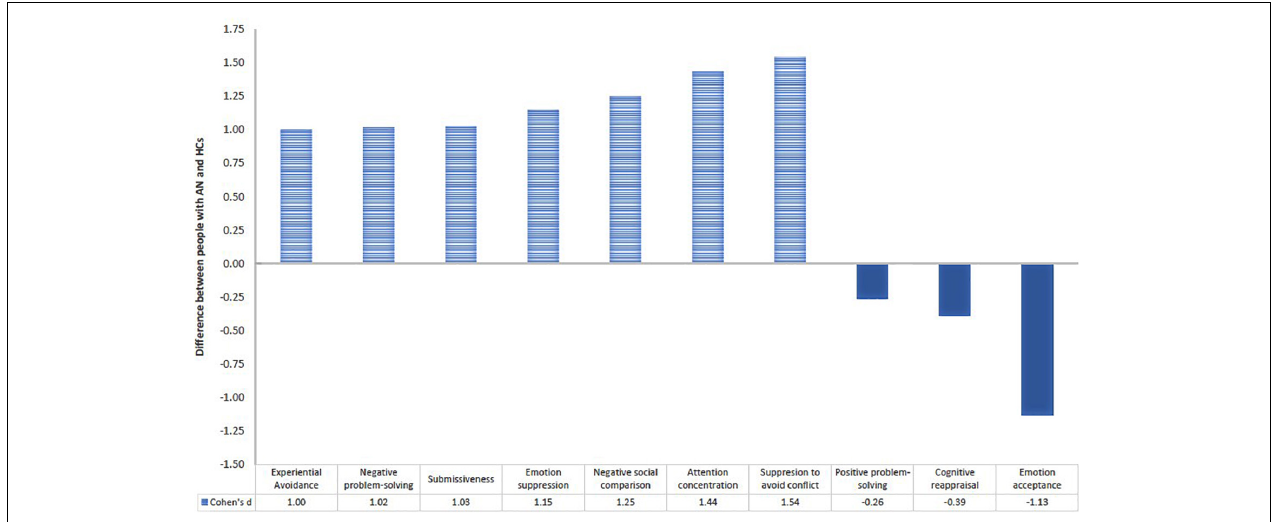
FIGURE 2 | Graph indicating difference between people with Anorexia Nervosa (AN) and healthy comparisons (HCs) in their use of maladaptive ( ) and adaptive ( ) emotion regulation strategies [adapted from Oldershaw et al.